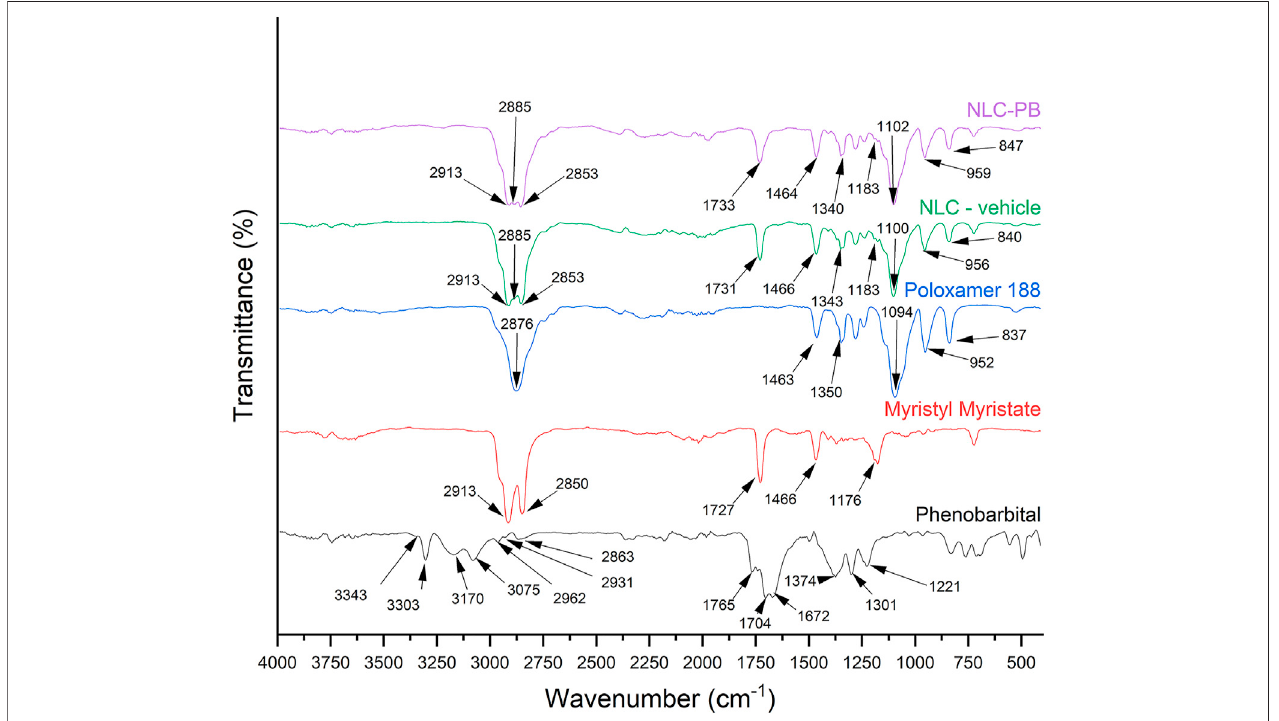
FIGURE 7 | Overlaid FTIR spectra of PB, myristyl myristate, Poloxamer 188, NLC-vehicle, and NLC-PB.